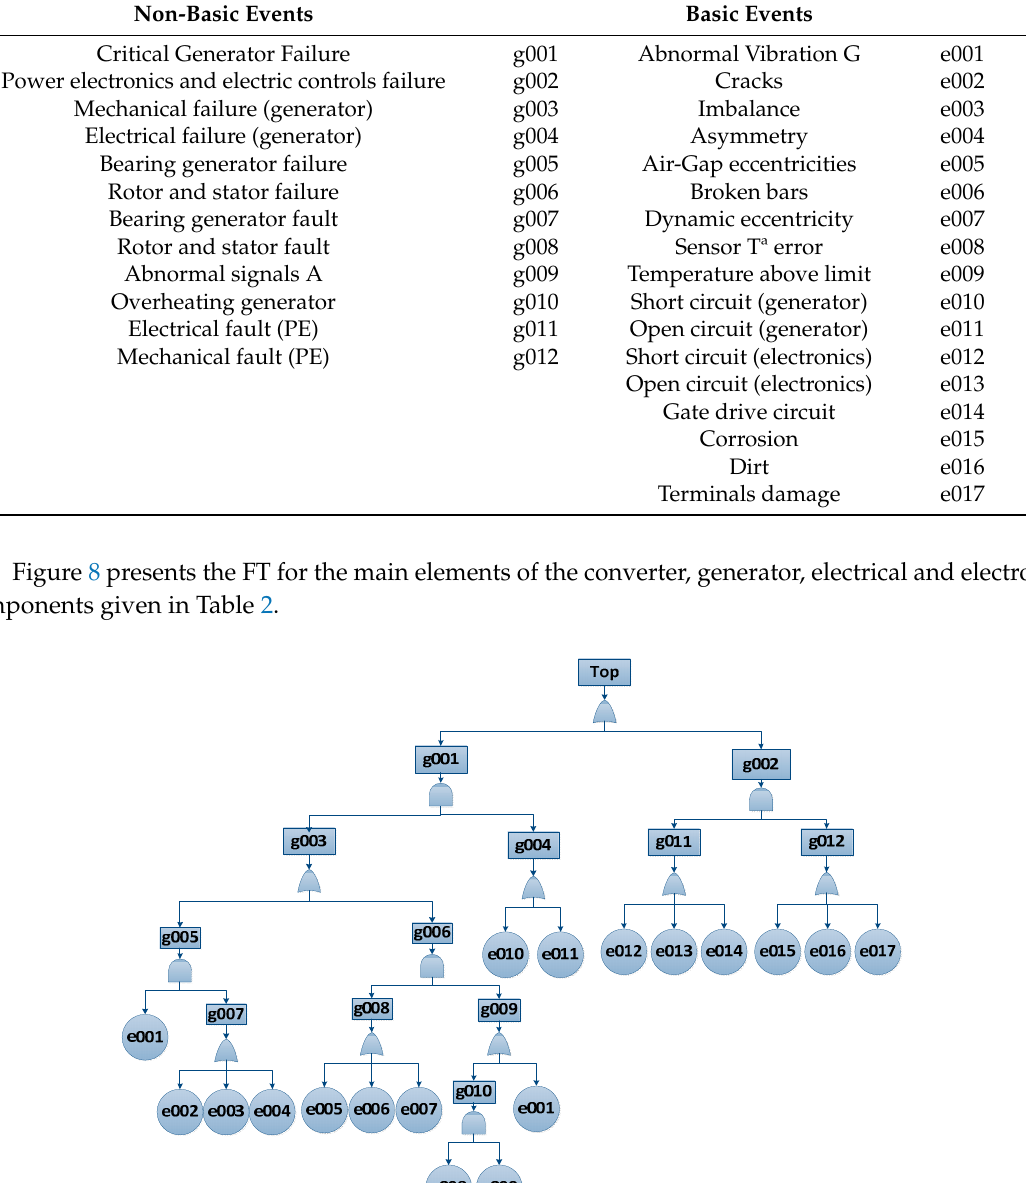
Table 3. Ranking methods and CSs.